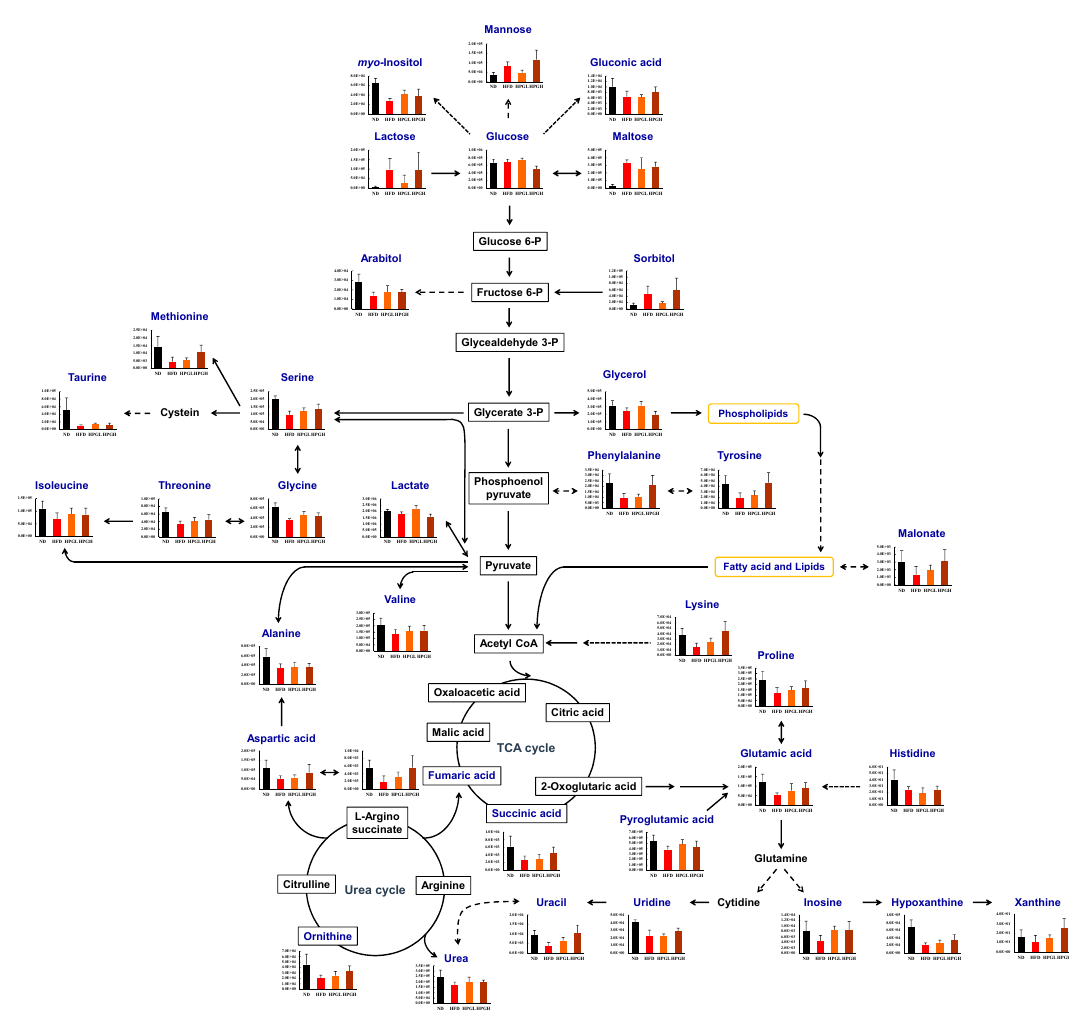
Figure 3. Proposed metabolic pathway derived from the metabolites significantly altered in liver tissues depending on the administration of Platycodon grandiflorum to High-Fat Diet (HFD)-induced obese mice. In the histograms, the peak intensity was plotted on the y-axis, while the different experimental groups were plotted on the x -axis. Black square ND, group fed with a normal diet; red square HFD, group fed with a high-fat diet; orange square HPGL, group fed with a high-fat diet and 1% P. grandiflorum ; brown square HPGH, group fed with a high-fat diet and 5% P. grandiflorum .